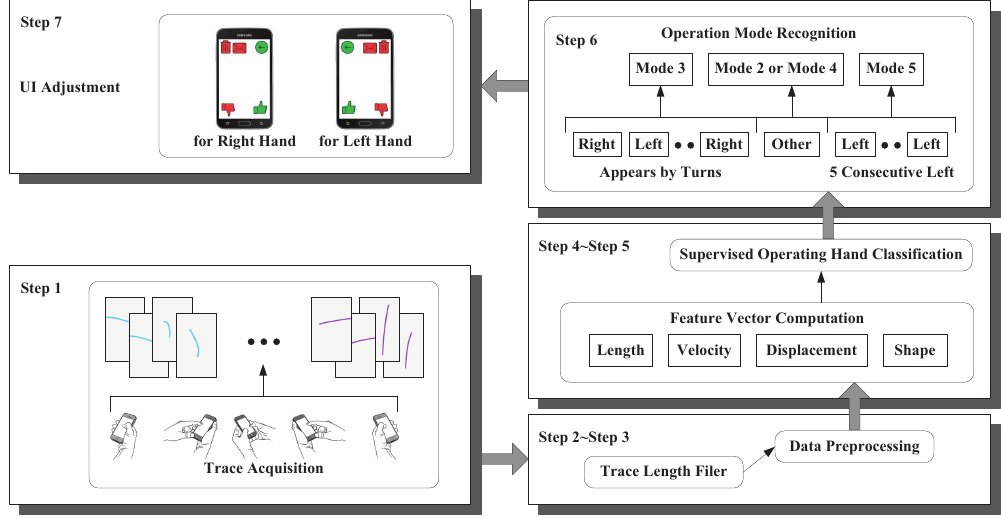
Figure 3. System overview of recognizing the current operating hand.